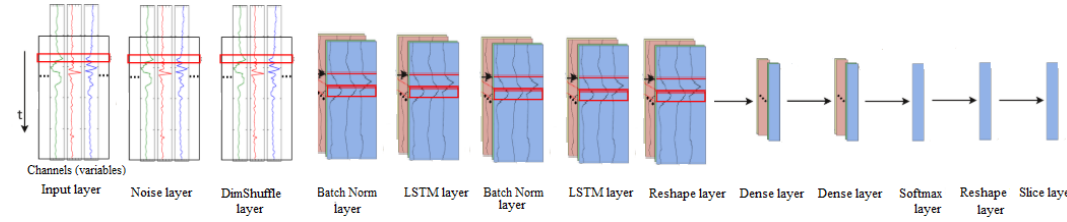
Figure 10. Architecture of the LSTM model for ice-jam prediction (adapted after Ordóñez and Roggen, 2016).